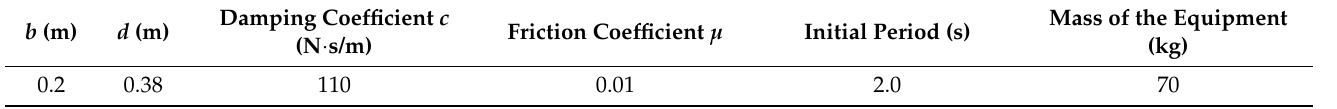
Table 6. The parameters of the variable-frequency pendulum